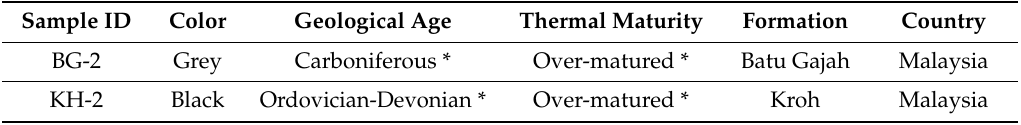
Table 1. Properties of the BG-2 and KH-2 shales.